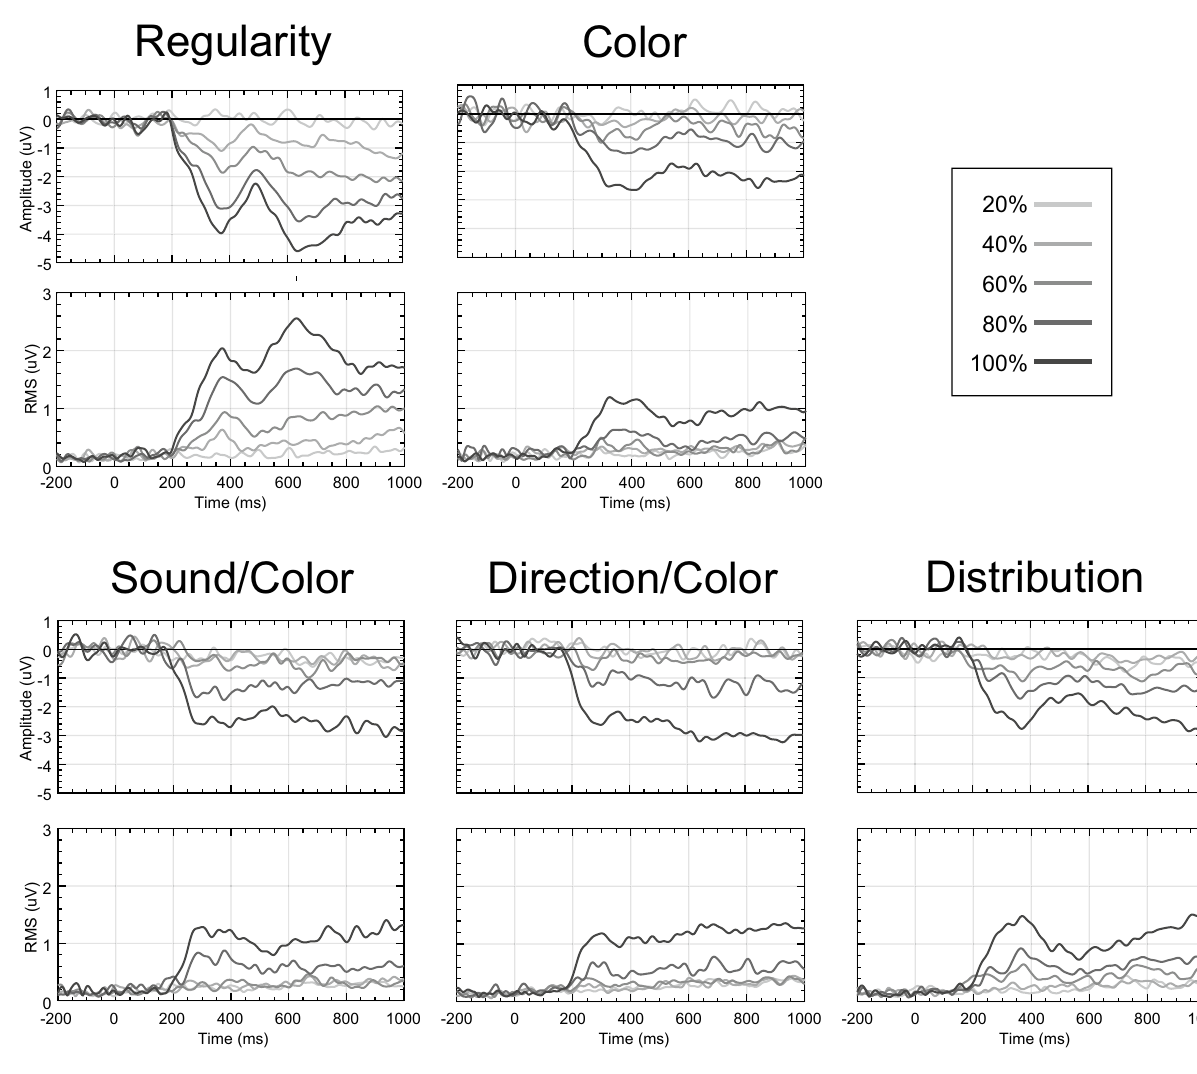
Figure 1. ERP and GFP for scalp level data. Top panels show grand average difference waves (PSYMM– random) at posterior electrode cluster [PO7, O1, O2 and PO8] for each task and level of PSYMM. The bottom panels show global field power (GFP) of the difference